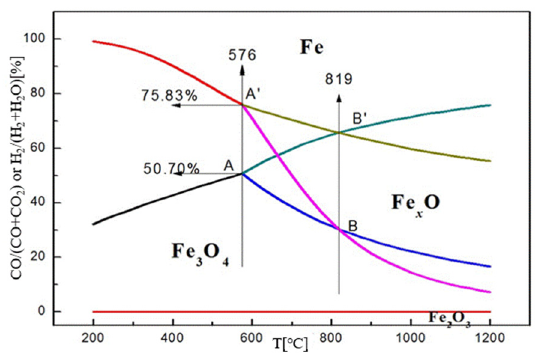
Figure 2. The predominance area diagram of iron oxide reduction reactions.